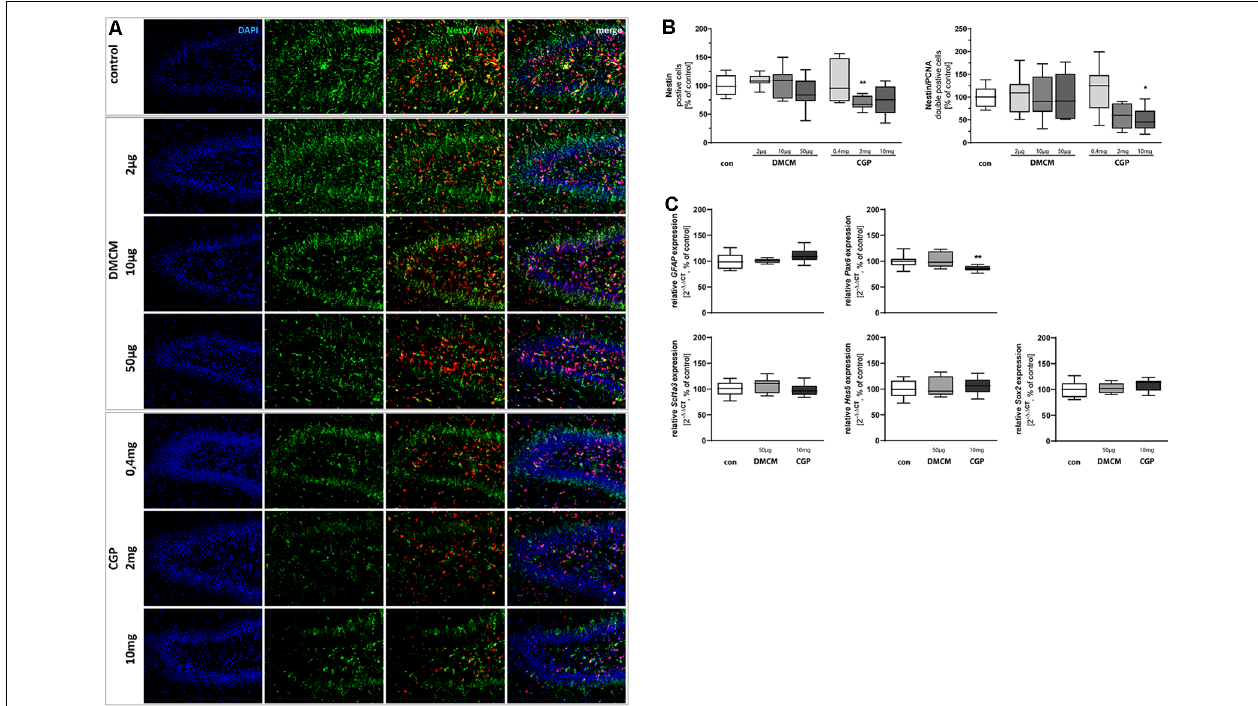
FIGURE 1 | Representative hippocampal paraffin sections (A) of control animals, DMCM hydrochloride (DMCM) in doses of either 2 µ g/kg, 10 µ g/kg or 50 µ g/kg, and CGP 35348 in doses of either 0.4 mg/kg, 2 mg/kg or 10 mg/kg treated rat pups at P11 co-labeled with DAPI, Nestin, and PCNA. Application of GABA B receptor antagonist CGP 2 mg/kg decreased Nestin positive progenitor cells in the dentate gyrus (DG). Application of CGP 10 mg/kg decreased the number of proliferating Nestin/PCNA double positive cells. Quantification of (B) Nestin and Nestin/PCNA double positive cells in sum of the DG in comparison to control group (100% white bars). Data are expressed relative to the control group as mean ± SEM of n = 10 each group. The 100% values are for Nestin+ 83.5 cell counts and for Nestin+PCNA+ 13.3 cell counts. * p < 0.05 and ** p < 0.01 vs. control (Brown-Forsythe test for Nestin+, Kruskal–Wallis test for Nestin+PCNA+). Expressions of (C) glial fibrillary acidic protein (GFAP) , Scl1a3 , Hes5 , and Sox2 are not affected by the application of DMCM or CGP. Pax6 expression is diminished in CGP treated animals. The relative mRNA expressions of markers were measured by quantitative real-time PCR in rat brain homogenates with DMCM 50 µ g/kg (gray bars) or CGP 10 mg/kg (black bars) application relative to control (white bars). Bars represent the relative mRNA quantification based on internal standard HPRT . Data shown as mean ± SEM, n = 9–10. ** p < 0.01 vs. control (Brown-Forsythe test for GFAP , one-way analysis of variance (ANOVA) for Scl1a3 , Hes5 , Sox2 , and Pax6 ).